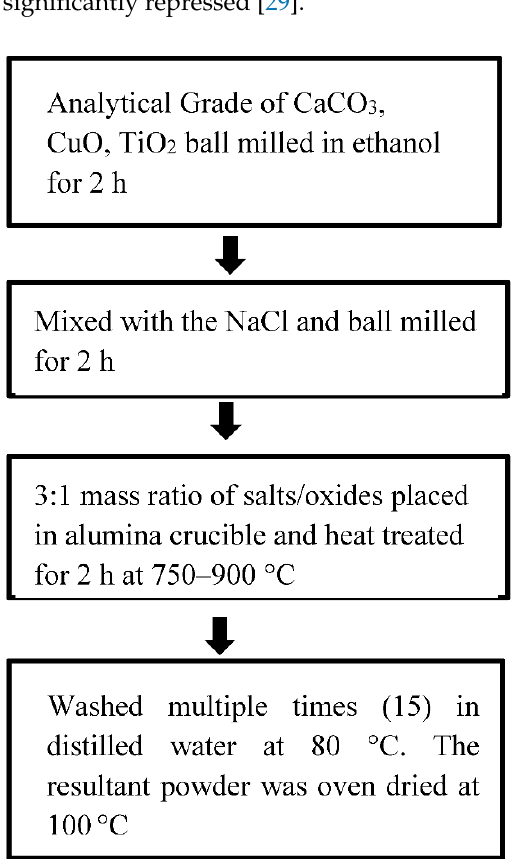
Figure 2. Flowchart of Molten Salt Synthesis .